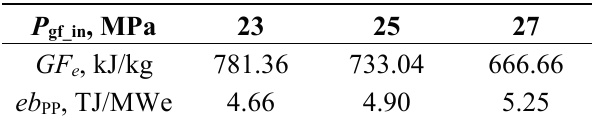
Table 2. Optimal efficiencies of the air-cooled triple-expansion plant as a function of P gf_in at T gf_in = 400